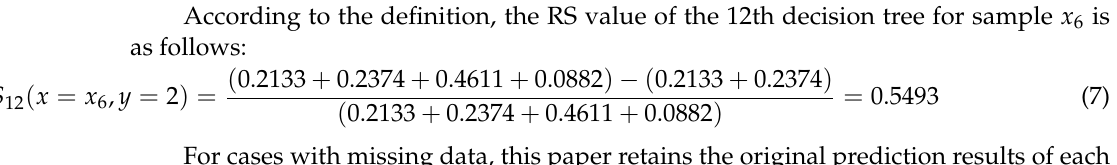
Figure 2. The process of classifying iris dataset with missing data.